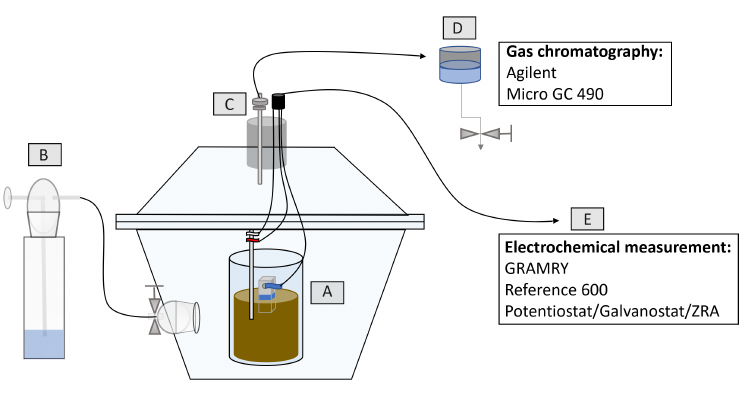
Figure 2. Setup of the GC and OCP measurements in parallel. Point A represents the aluminum sample embedded in the cement paste, connected to the electrochemical measurement within the desiccator. Point B represents the system’s pressure gauge, and point C the outlet for the wires for the electrochemical measurement and the gas to be analyzed by the gas chromatograph. Point D represents the Agilent 490 Micro GC, and point E the Reference 600 Potentiostat by GAMRY Instruments, analyzing the gas composition and the OCP during the cement